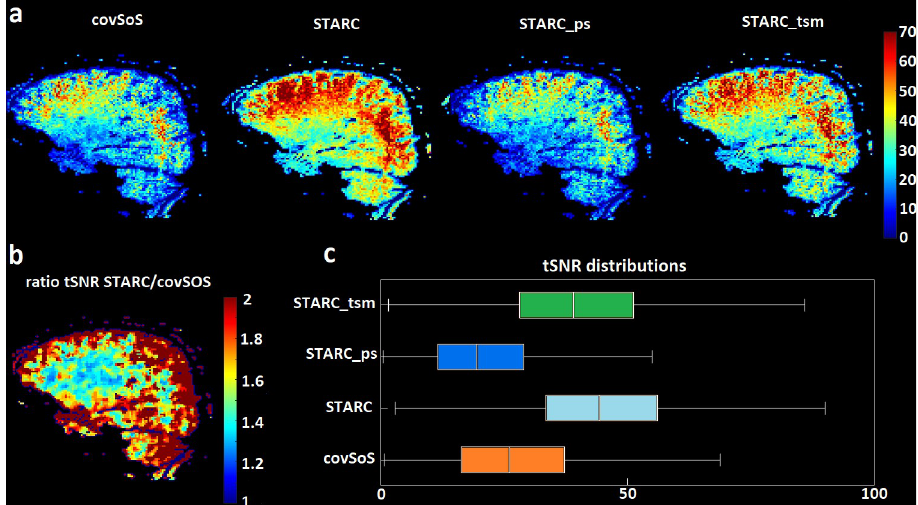
Fig 1. tSNR results. a–tSNR map from the same volunteer, scan and sagittal slice after covSoS, STARC, STARC ps and STARC tsm coil combinations. STARC yielded the highest tSNR map. b–Ratio of STARC and covSoS tSNR maps after median image filtering. STARC always improves tSNR, up to a factor 2. c–tSNR distributions pooled across all volunteers. Overall, STARC outperforms the other coil combinations in terms of tSNR. A brain mask was used to ignore non brain voxels.